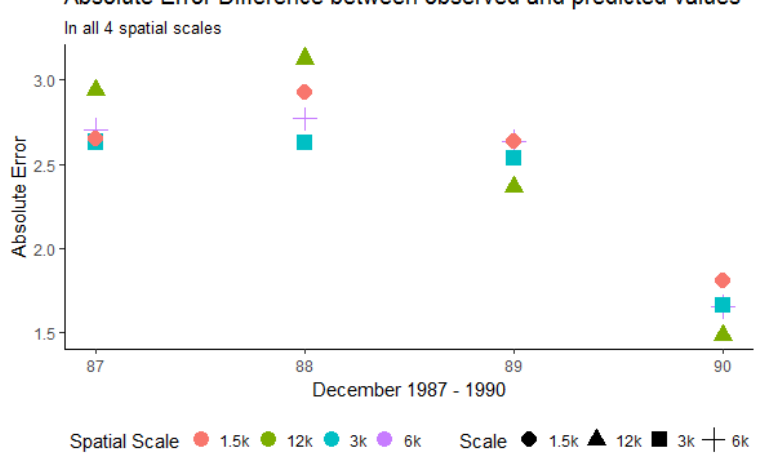
Figure 17. Quantitative assessment of absolute error rates in the four spatial